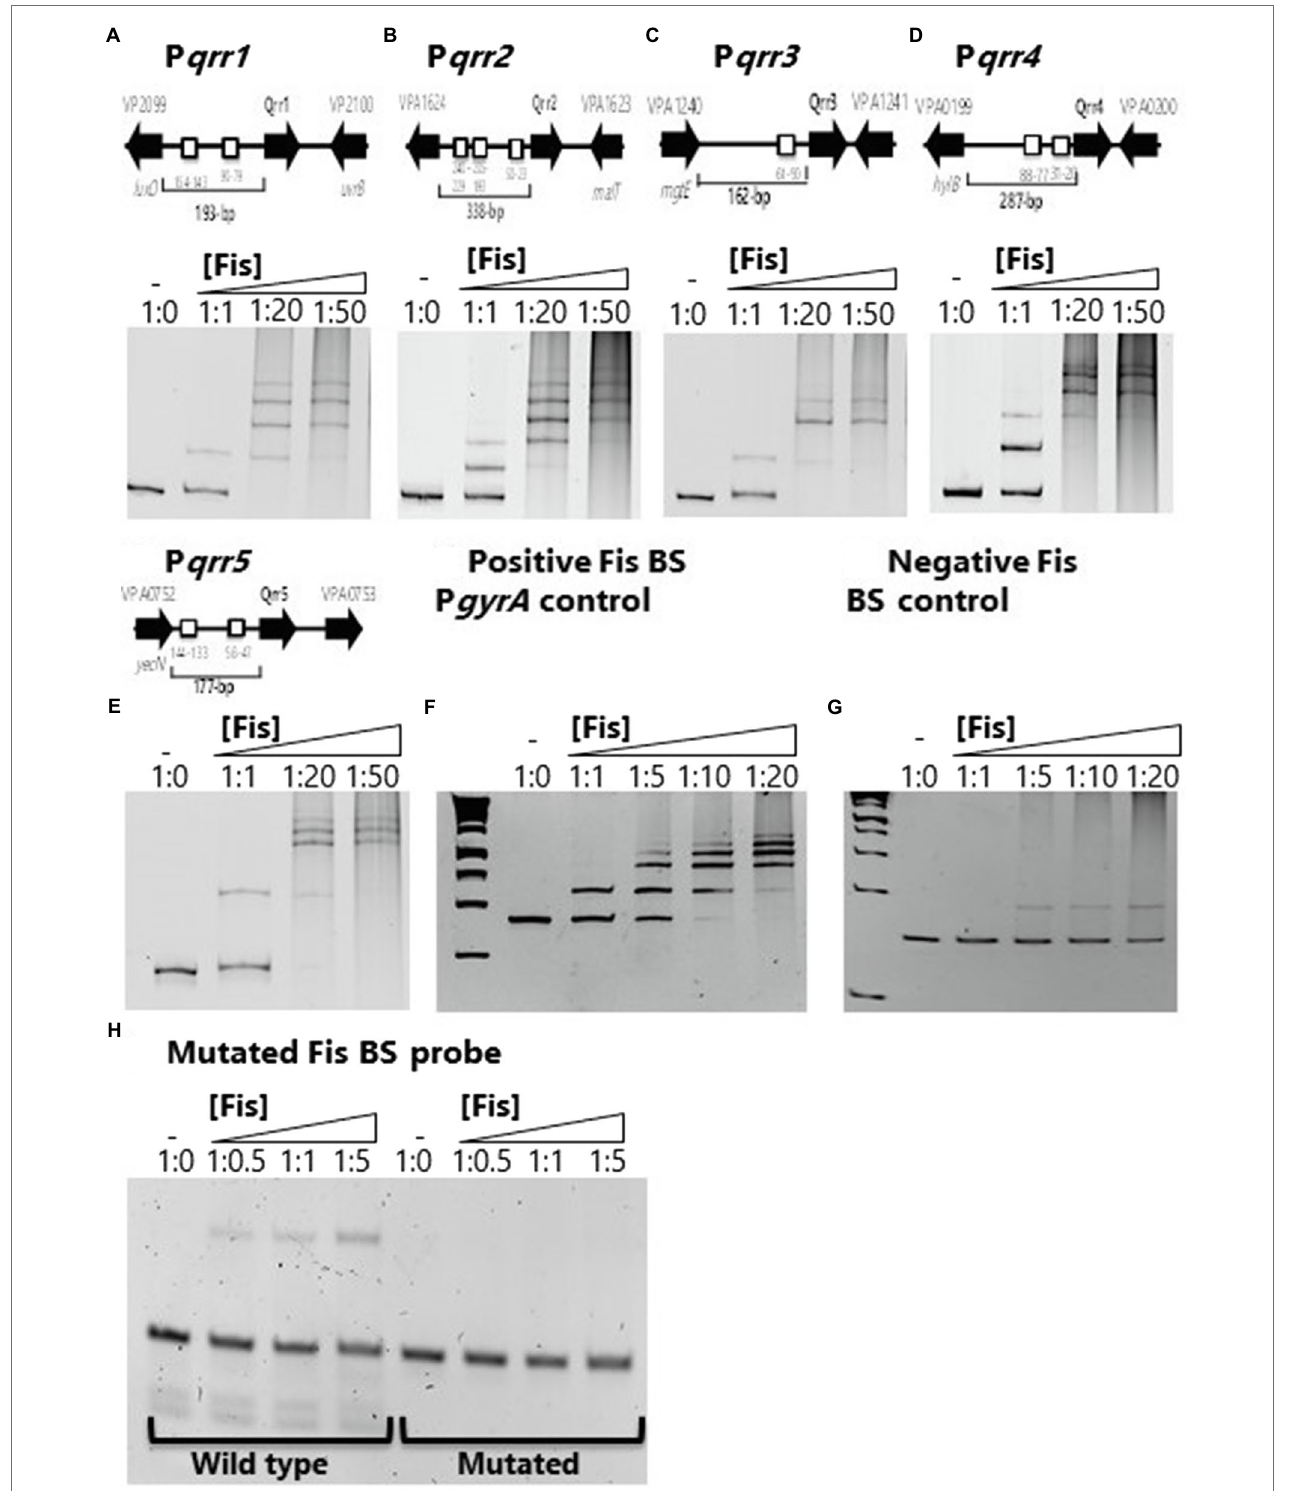
FIGURE 1 | Factor for inversion stimulation binds to the regulatory regions of V. parahaemolyticus regulatory sRNAs (A) qrr1 , (B) qrr2 , (C) qrr3 , (D) qrr4 , and (E) qrr5 . A putative Fis binding site (BS) is shown as a box in the regulatory region of qrr1 to qrr5 . Electrophoretic mobility shift assays (EMSA) using purified Fis and the regulatory regions of qrr1 to qrr5 . DNA:protein ratios are as follows: 1:0, 1:1, 1:20, 1:50. (F) Positive Fis BS control in gyrA regulatory region showing complete shift at all concentrations. (G) Fis non-binding negative control using DNA with no putative Fis BS showing weak non-specific binding and no shift at lowest concentration. (H) qrr3 probe containing a single Fis BS (wild type) and a mutated BS demonstrating specificity of Fis